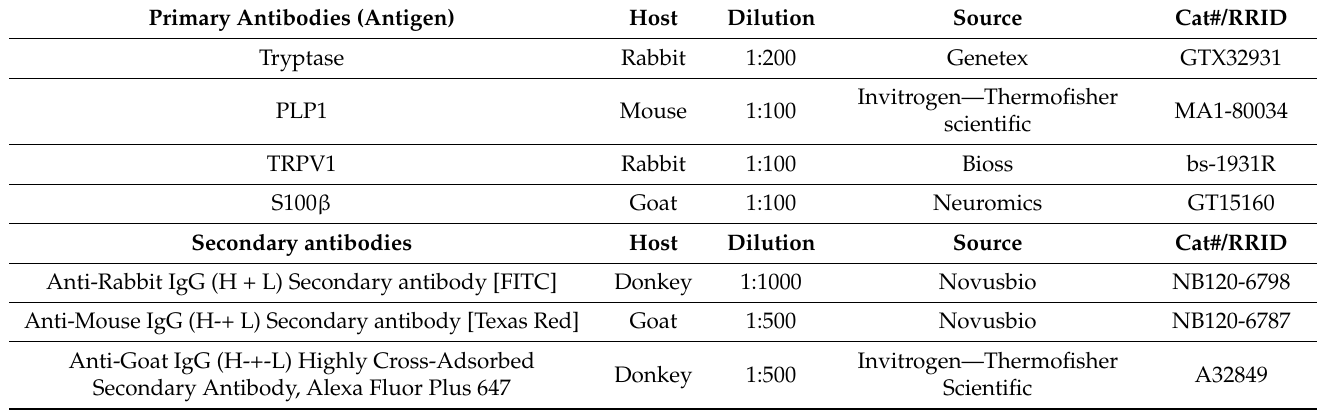
Table 1. Antigens and antibodies used in